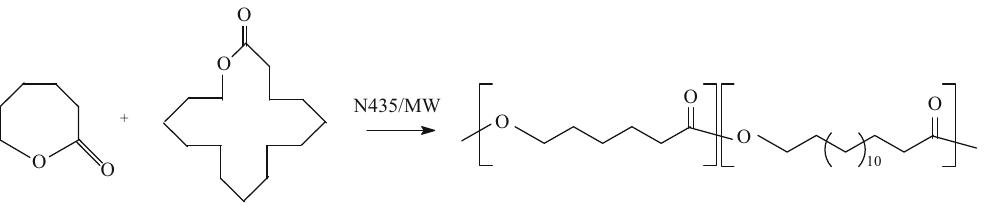
Figure 1: MW - assisted ring - opening copolymerization of ε - CL and ω - PDL catalyzed by novozyme 435 ( N435 ) and microwave.